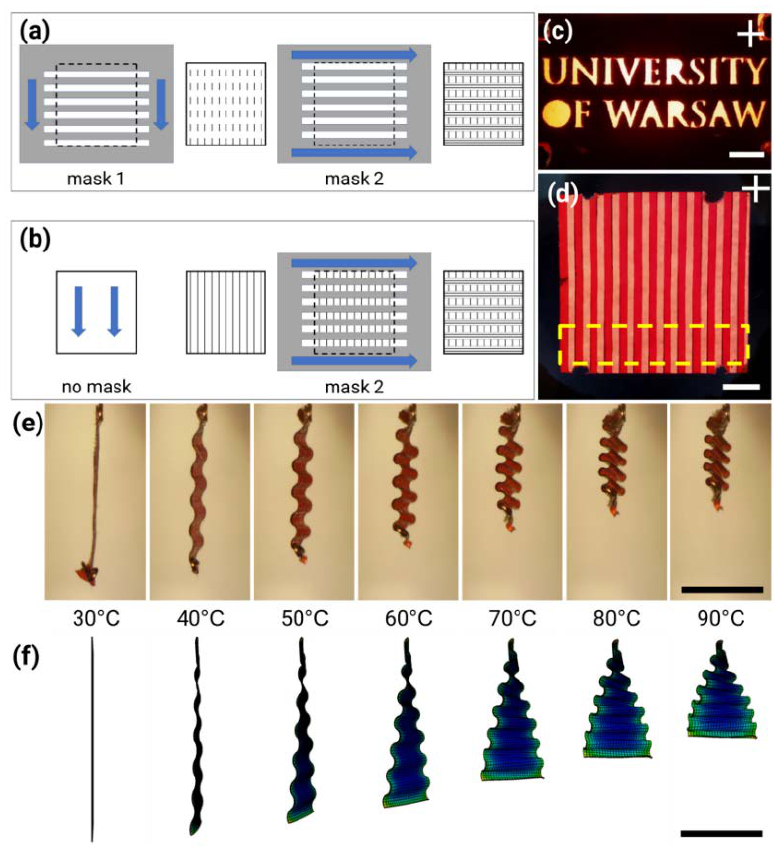
Figure 23. All scale bars are 5 mm long. ( a ) Two masks (gray) were used, one for each rubbing direction indicated by blue arrows and gray lines. ( b ) In the rubbing overwriting method, the entire surface is rubbed in one direction first and one mask is used for the regions with a perpendicular rubbing direction. ( c , d ) LCE films prepared with the rubbing overwriting technique using: ( c ) a mask with the University of Warsaw logo cut out and ( d ) a mask with 1 mm wide slits cut out. The yellow box shows how the accordion-like actuator was cut from the film. White light photographs were taken between crossed polarizers, with the white cross showing the orientation of the polarizers. ( e ) Accordion-like deformation in a stripe of LCE film cut perpendicular to the pattern lines, heated from 30 ◦ C to 90 ◦ C. ( f ) Finite element simulation of the LCE stripe deformation. Temperature values relate to conditions in ( e , f ) (Reprinted with permission from Rog ó ˙z, M., et al. [159]. Copyright 2021, CC BY 4.0